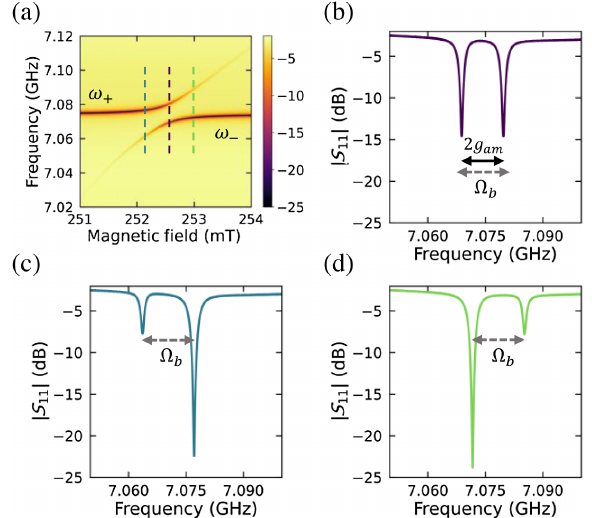
FIG. 2. Normal mode spectrum. (a) Measured normal mode spectrum as a function of static magnetic field. Dashed lines correspond to the spectrum in (b) – (d). (b) Cavity reflection spectrum when the magnon is resonant with the bare-cavity mode. The normal mode splitting 2 g is smaller than the phonon am 2 π × 12 . 6278 MHz. (c) Cavity reflection spec- frequency, Ω b ¼ trum when the magnon frequency is smaller than the bare-cavity resonance frequency. The system was set up such that the normal mode spacing matches the mechanical frequency. Here the lower mode is “ magnonlike ” and the upper mode is “ photonlike. ” (d) Cavity reflection spectrum when the magnon frequency is larger than the bare-cavity resonance frequency, similar to the detuning in (c). Here the upper mode is magnonlike and the lower mode is